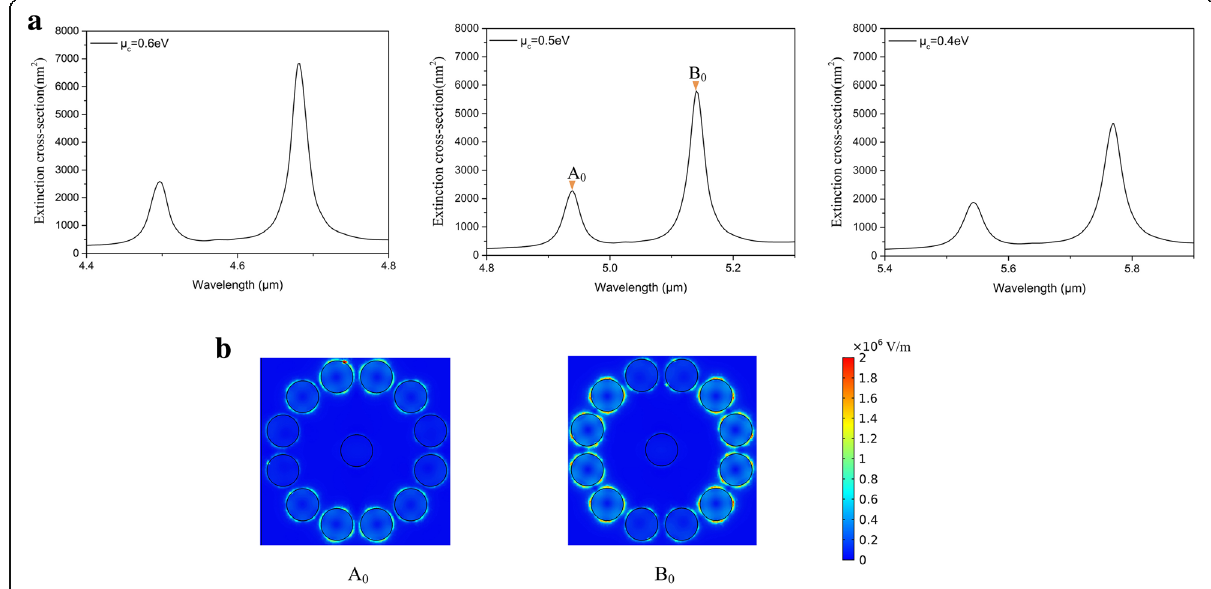
Fig. 2 a The extinction spectra of graphene oligomer with the chemical potential ranging from 0.4 to 0.6 eV. b The simulated electric fields (|E|) at the two resonance